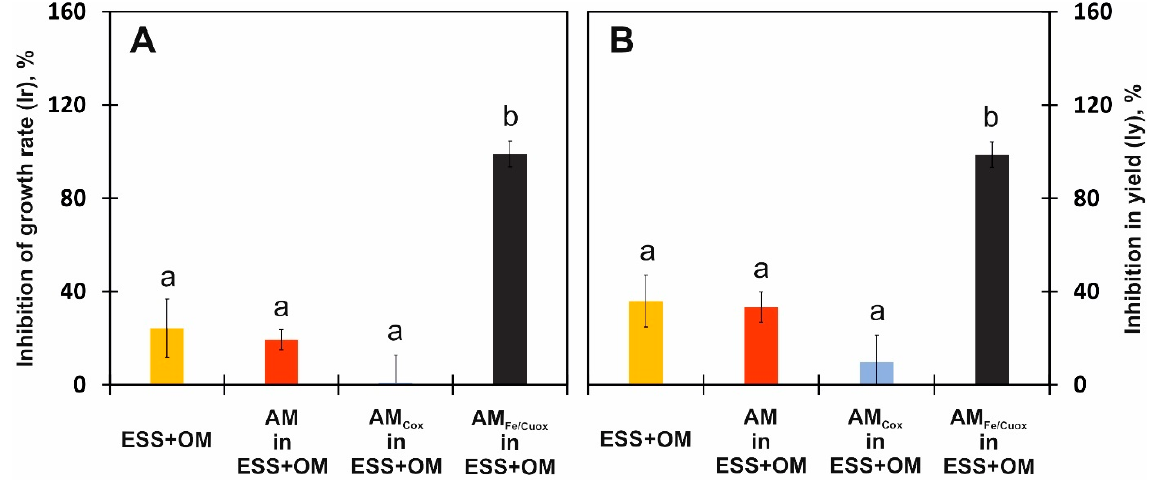
Figure 5. Inhibition of growth rate (Ir) ( A ) and inhibition in yield (Iy) ( B ) of L. minor exposed to OM, ESS+OM; AM in ESS+OM; AM Cox in ESS+OM; AM Fe/Cuox in ESS+OM. The data points represent the mean ± SD, n = 6. Values are significantly different from the control at p < 0.01 (a,b). The FM of L. minor new fronds was found to be highest (16 mg) in OM. Among the samples contaminated with dyes, the highest FM = 12.27 mg was recorded in AM Cox in ESS+OM (statistically not different from the control sample), while no new leaves appeared in AM Fe/Cuox in ESS+OM (0.37 mg); FM did not increase. At the same time, the FM of L. minor growing in AM in ESS+OM was 8.88 mg, and the one exposed to ESS+OM—7.44 mg (Figure